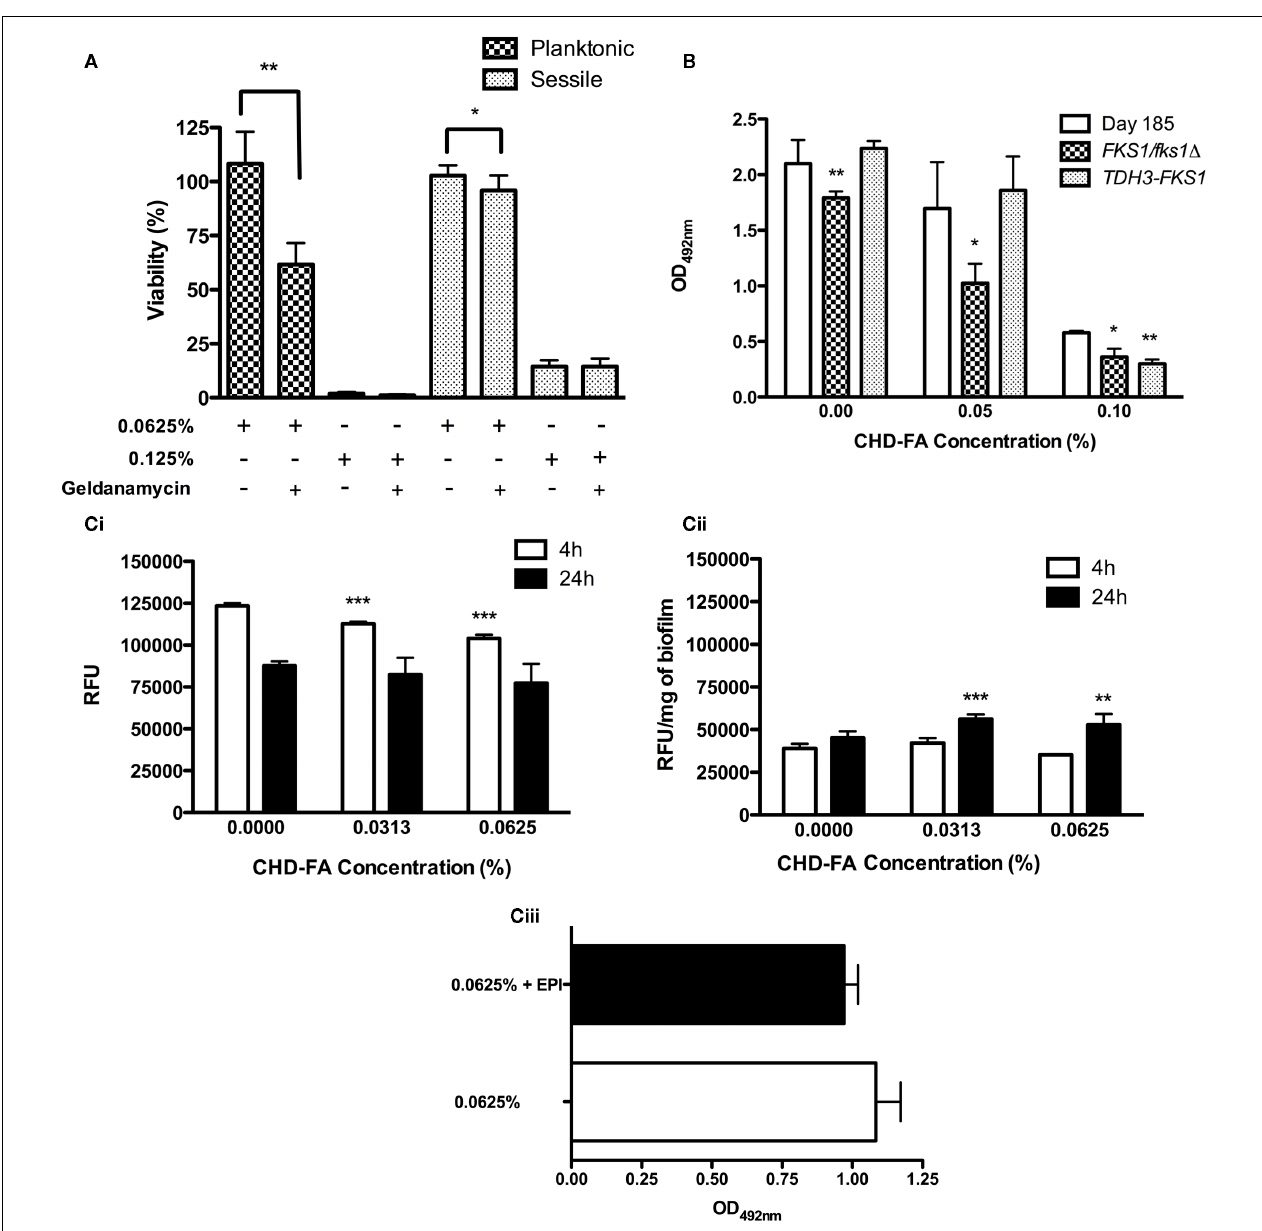
of FKS1/fks1 Δ to the reference strain DAY185. (C) C. albicans SC5314 was grown as (i) planktonic and (ii) biofilm cells and treated with 0.0313 and 0.0625% CHD-FA (sub-MIC levels) for 4 and 24h. Cells were washed, resuspended in assay buffer and 100 μ g/ml of Ala-Nap added.These were then transferred to a black 96-well plate for quantification at 30s intervals over 60min in a fluorescent plate reader (Ex 355 /Em 460 ). For biofilms